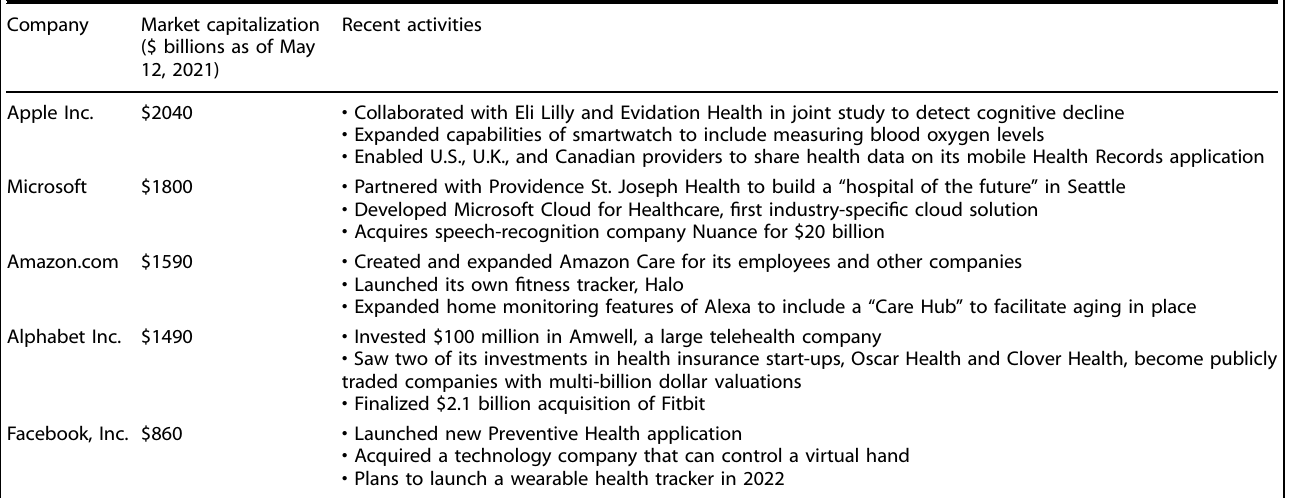
Table 2. Select investments in health by the largest technology fi rms, 2019 – 2021.